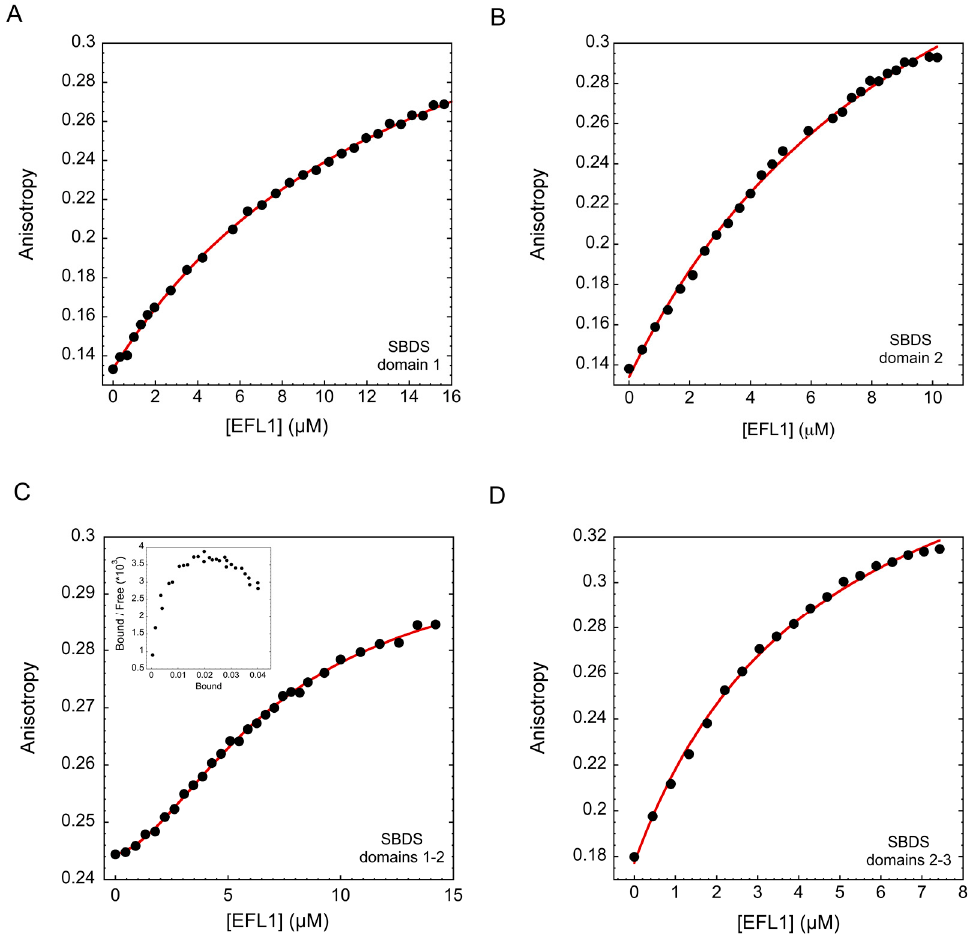
Figure 2. Binding of human EFL1 to different domains of human SBDS, evaluated by fluorescence anisotropy. ( A ) Domain 1, ( B ) Domain 2, ( C ) Domains 1–2, ( D ) Domains 2–3. Continuous line represents the fit of the data to a single binding site model except for plot (C), where data were fitted to a two different binding sites model. Inset in (C) corresponds to the Scatchard plot.